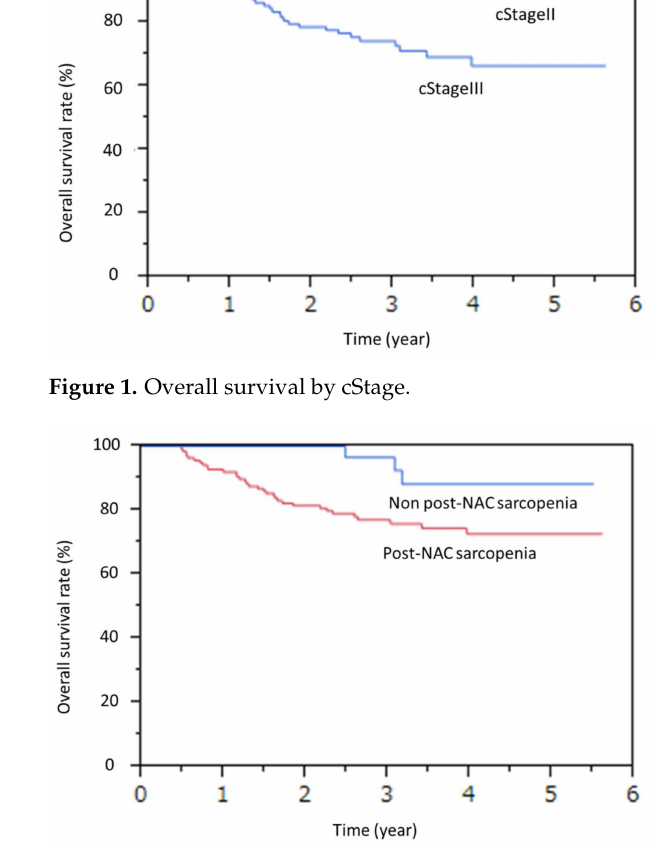
Figure 2. Comparison of overall survival between Post-NAC sarcopenia and Non post-NAC